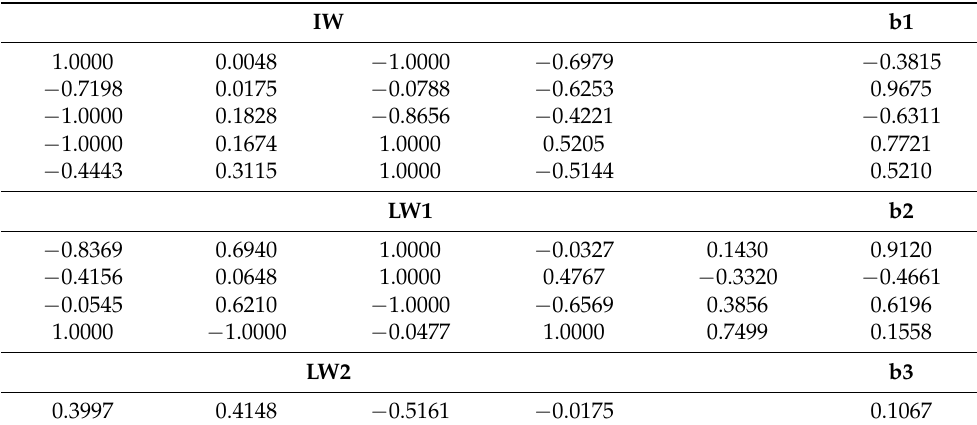
Table 9. Final bias and weight values of the developed PCA-ABC-ANN technique.